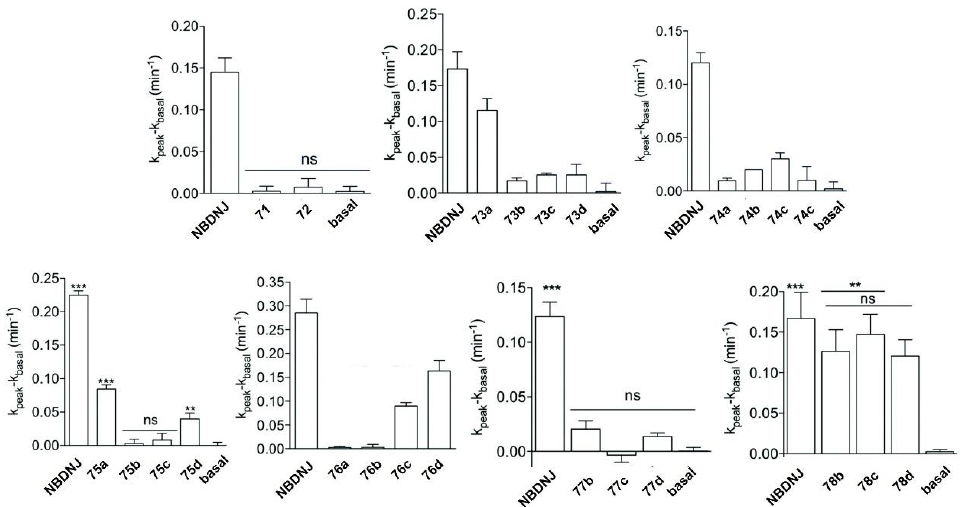
Figure 16. Azepane iminosugars as F508del-CFTR correctors. ** p < 0.01; *** p < 0.001; ns, not significant. This figure is republished with permission of the Royal Society of Chemistry, from [156]; permission